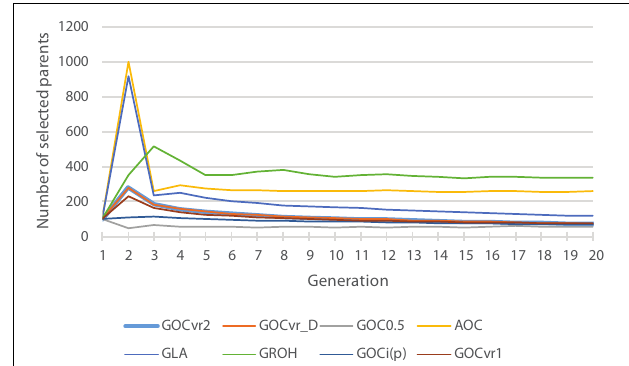
FIGURE 2 | The total number of selected parents for each generation for different breeding schemes. The total is the number of animals with optimal contributions > 0 required to achieve a fractional increase in the OC constraint of